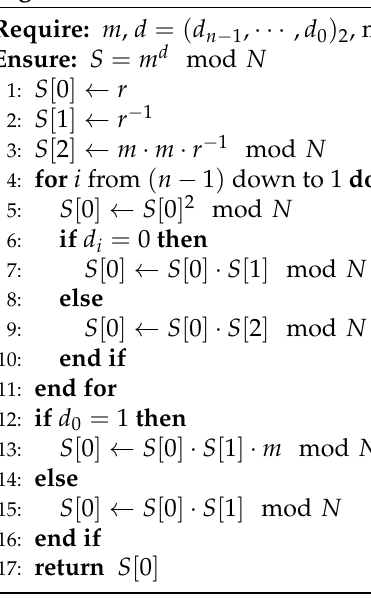
Algorithm 5 Modified BRIP